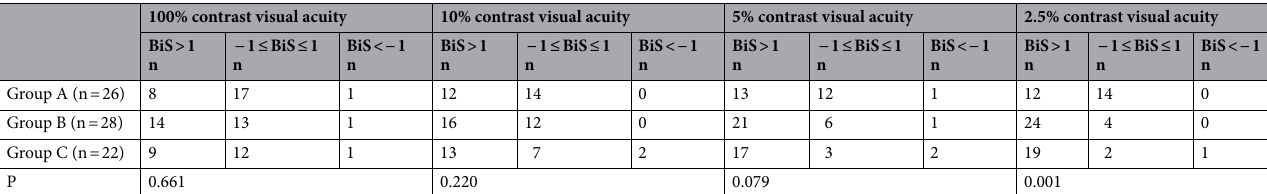
Table 2. The numbers of the patients with different BiS Scores after strabismic Surgeries. Depending the results of distant RDS: A, nil, unable to recognize; B for moderate, 200 ″ ≤ RDS ≤ 400 ″ , C for good, RDS < 200 ″ . The proportion of the patients with different BiS at 2.5% contrast differed significantly among three groups (P = 0.001). n number, BiS binocular summation.